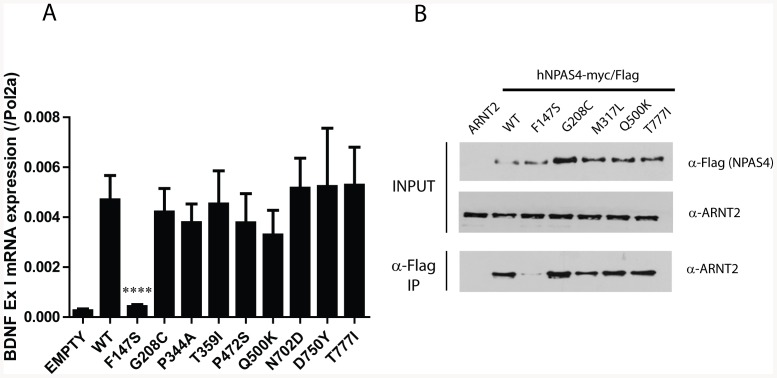
NPAS4 Variant F147S reduces dimerisation with ARNT2 and fails to activate BDNF expression.A, 293TREX cells containing site specific, stable integration of WT NPAS4-mycFlag, NPAS4-mycFlag variants or an empty vector were induced with 1 µg/ml doxycycline for 24 hrs and Brain Derived Neurotrophic Factor (BDNF) Exon I mRNA expression measured by quantitative real-time PCR and normalised to RNA Polymerase 2A. Data are mean ±SEM of at least 4 independent experiments; WT is an average of two independently derived cell lines and least 4 independent experiments. Statistical significance is calculated using an ANOVA compared to WT NPAS4-mycFlag, ****p<0.0001. B, Immunoblotting of whole cell extracts and α-Flag coimmunoprecipitates from HEK293T cells transiently transfected with NPAS4-MycFlag and ARNT2 expression constructs. α-Flag Abs used to detect NPAS4-MycFlag and α-ARNT2 Abs used to detect overexpressed ARNT2. Data are representative of three independent experiments.